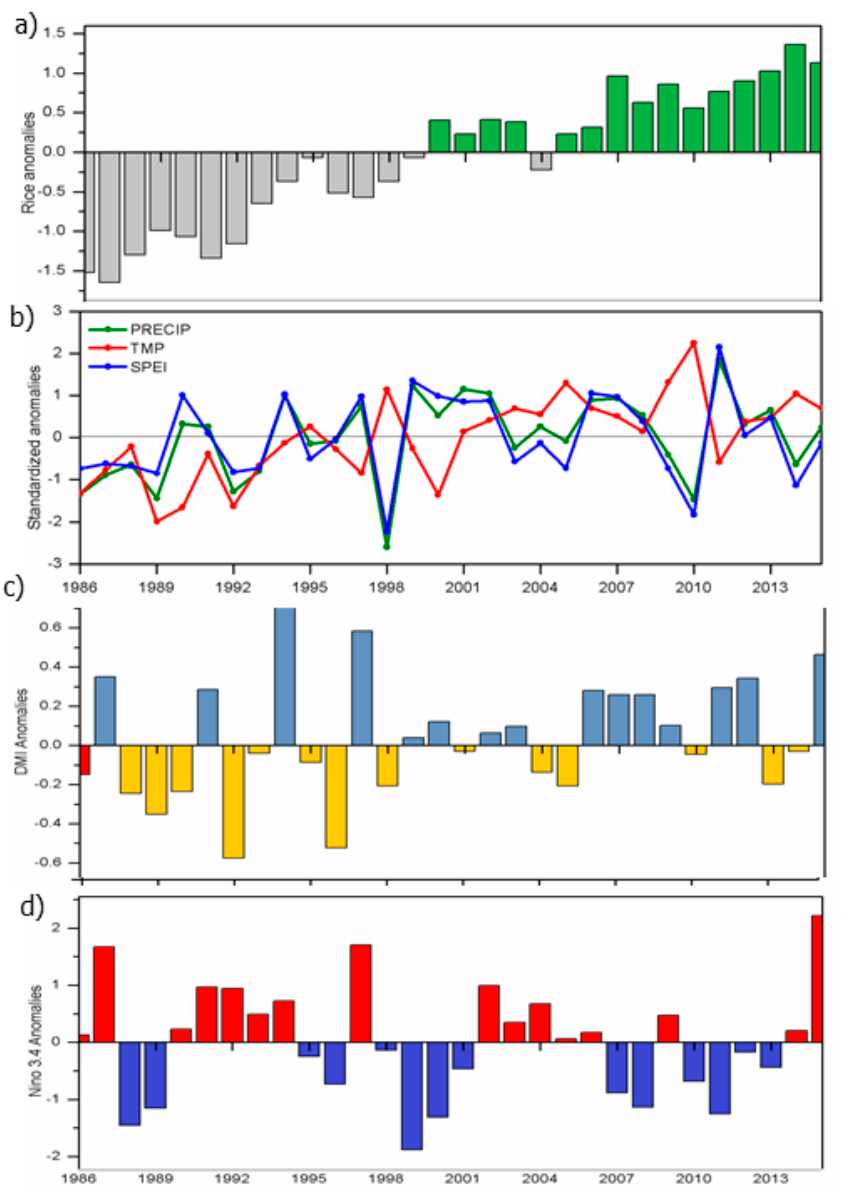
Figure 11. Interannual variability of ( a ) Rice production anomalies in Myanmar from 1986 to 2015 ( b ) Wetness and Dryness conditions expressed in three anomalies forms (green-precipitation, red- temperature, red-SPEI) ( c ) DMI anomalies, ( d ) Nino 3.4 SST anomalies during the same time